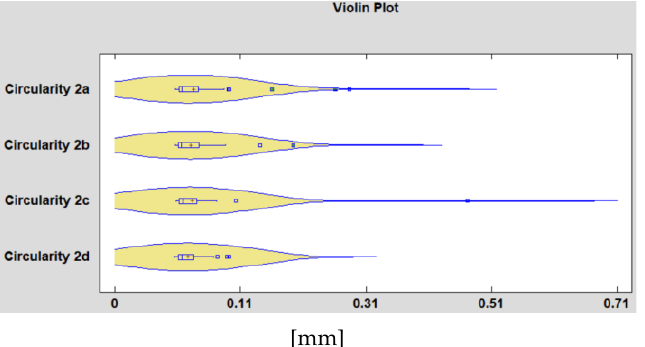
Figure 5. Comparative violin plot showing the measured values for the four holes on the sample’s P1 measurement plane’s deviation from circularity.